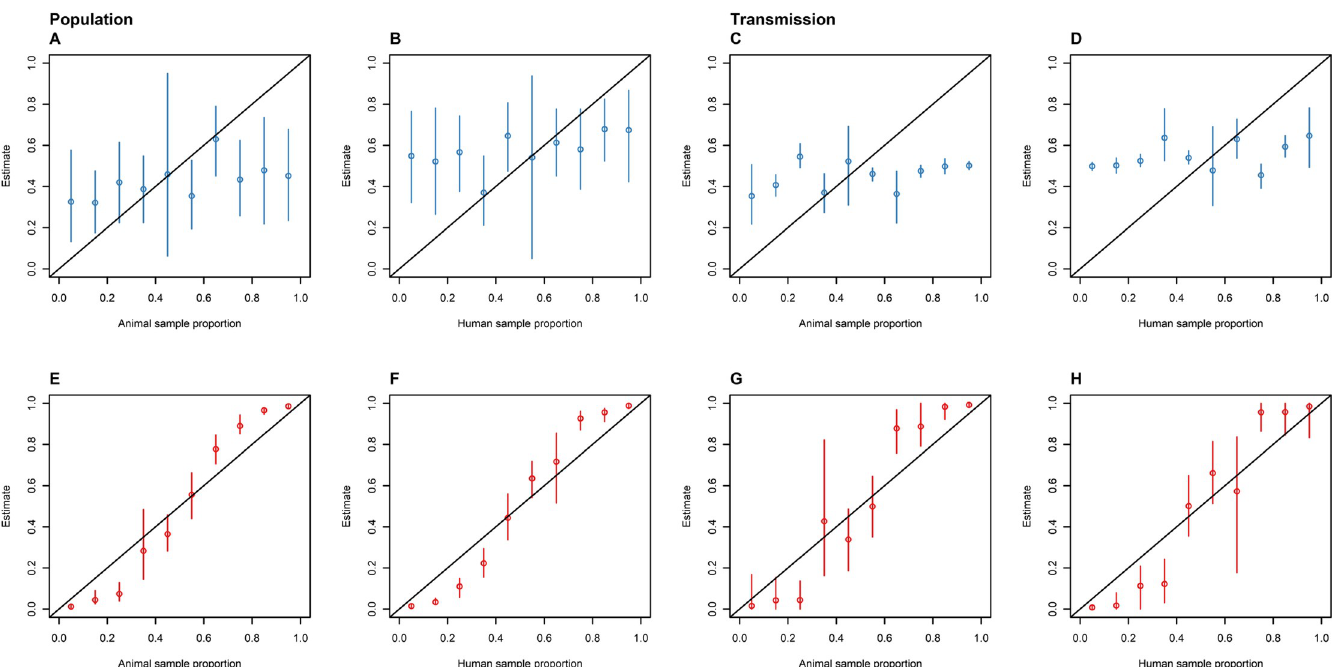
Fig 5. The proportion of time spent in the animal (A and E) and human (B and F) host populations, and the proportion of inter-population transmissions made up of animal-to-human (C and G) and human-to-animal (D and H) transmissions as estimated by the SC (blue: A-D) and DTA (red: E-F) models versus the proportion of sampled isolates that are animal (A, C, E and G) and human (B, D, F and H) for the same outbreak that was disproportionately sampled. The diagonal line represents accurate parameter estimates of the sampled outbreaks, the dots represent the mean, and the error bars represent the 95% HPD